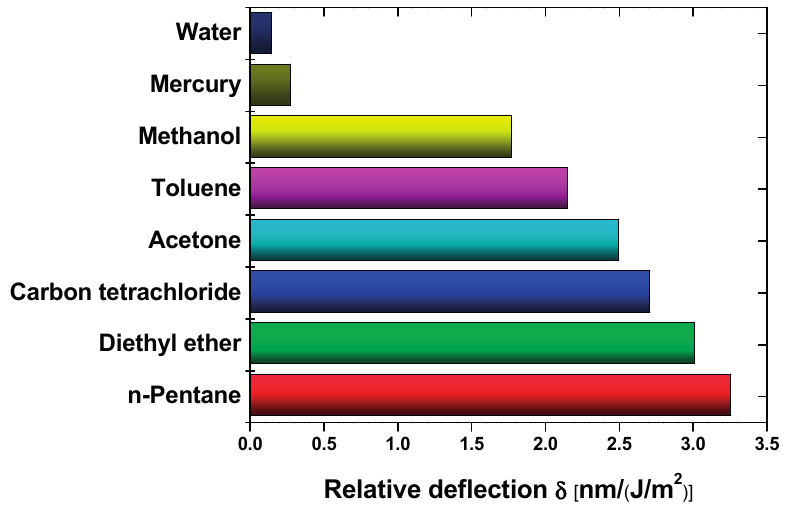
Figure 15. Comparison of the relative deflection δ of the membrane for different fluids (isobaric case, Ω >>1, see Equation (9)). For the same cross section of the cavity, the relative deflection is caused by the same amount of energy absorbed in the